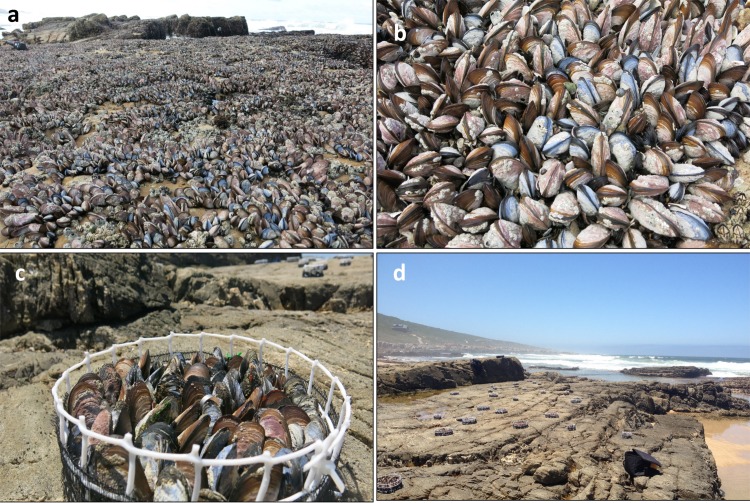
(a-b) Photos of mixed mussel beds within the midshore region at Jongensfontein, South Africa. The invasive mussel Mytilus galloprovincialis is easily distinguished from the indigenous mussel Perna perna by its blue colouration. (c-d) Experimental manipulations of mussel beds: artificial mussels beds were created by filling circular cages (20 cm diameter) with the desired size and density of the two mussel species (c). These were then placed high on the shore during a summer low-tide to simulate an extreme heat-event (d).